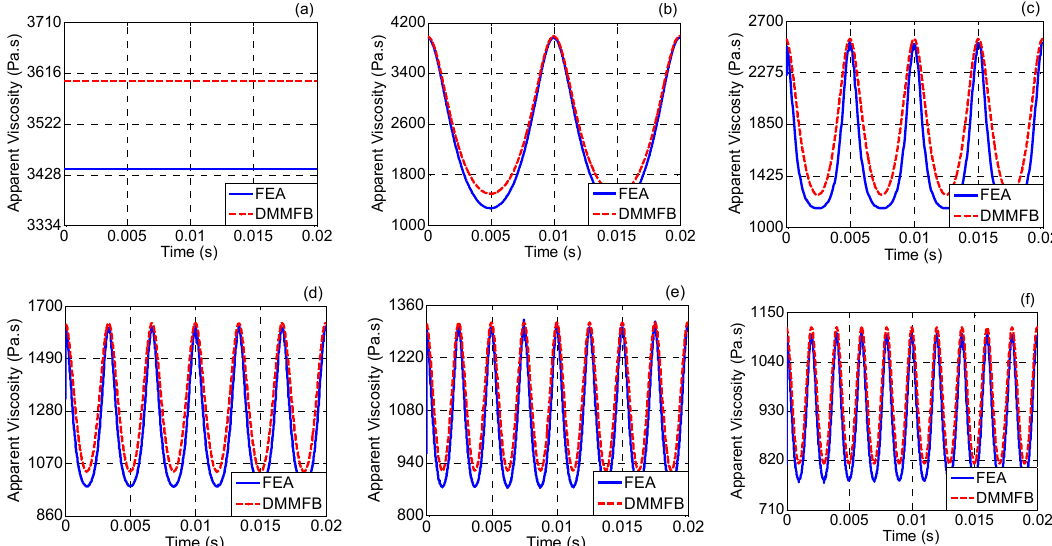
Figure 13. The apparent viscosity without and with 0.3 g vibration applied at different frequencies.